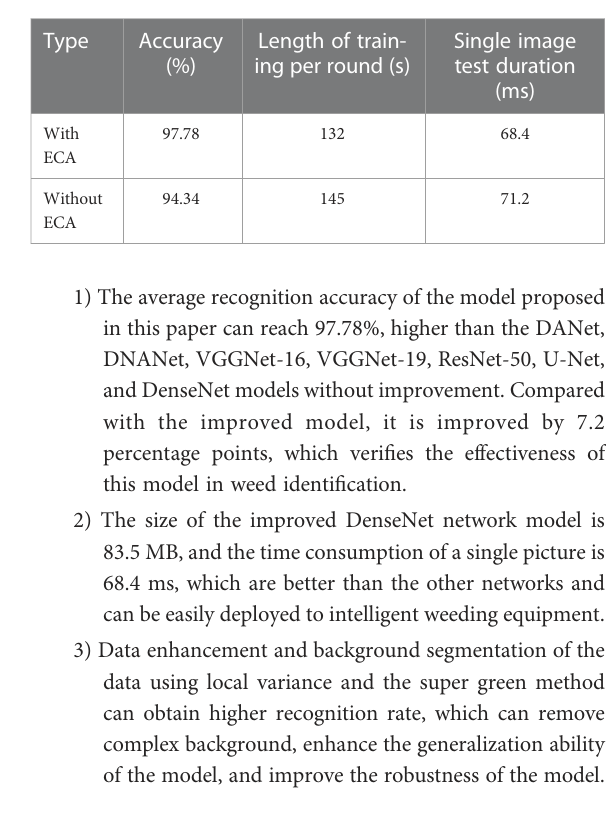
TABLE 6 Experimental results of our model with and without